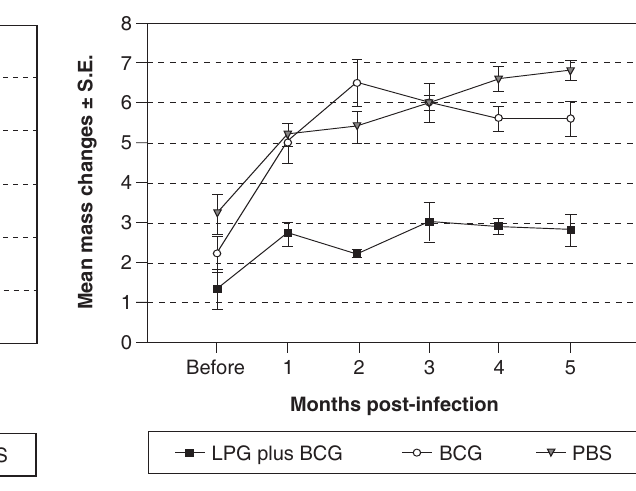
FIG. 6 Mean mass gain in immunized BALB/c mice following challenge with virulent L.